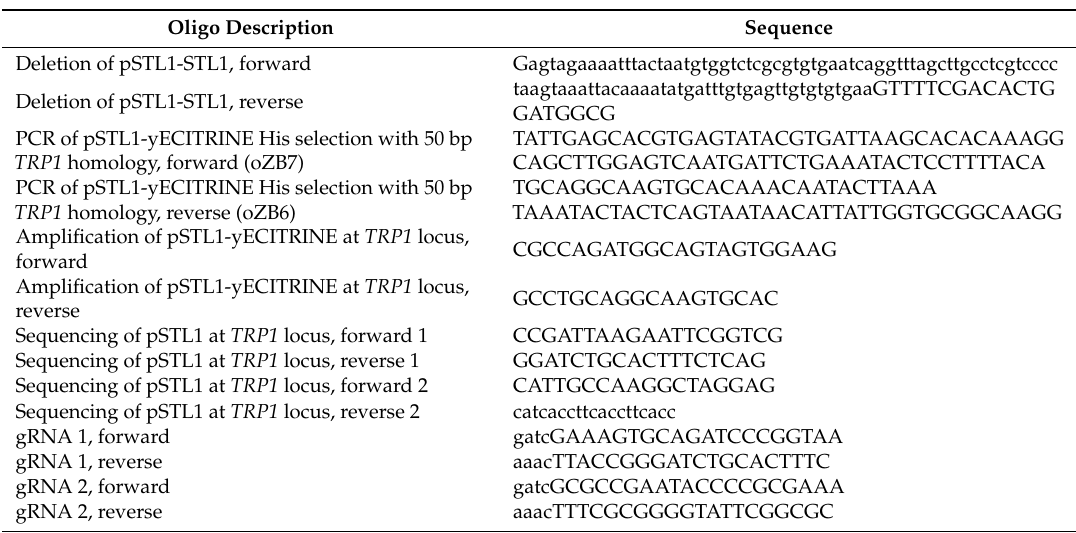
Table A2. List of primers.